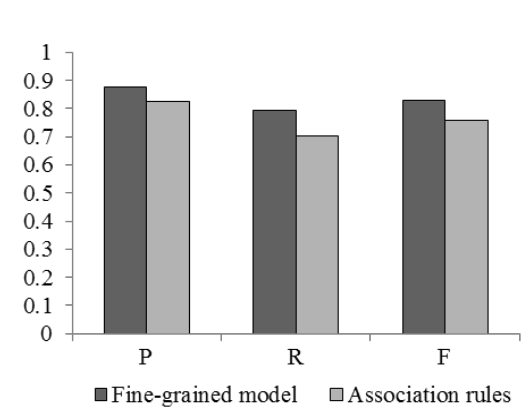
Fig. 3. Emotional element detection result comparison on product reviews